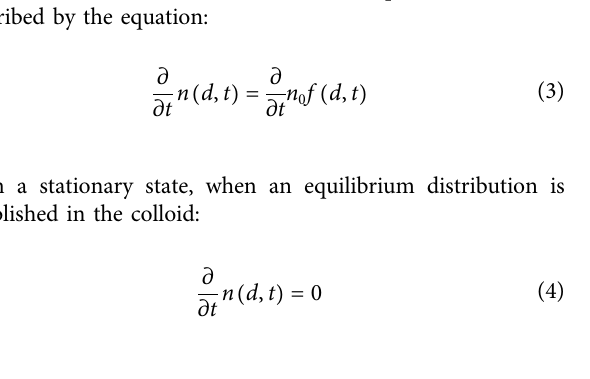
Frontiers in Physics |